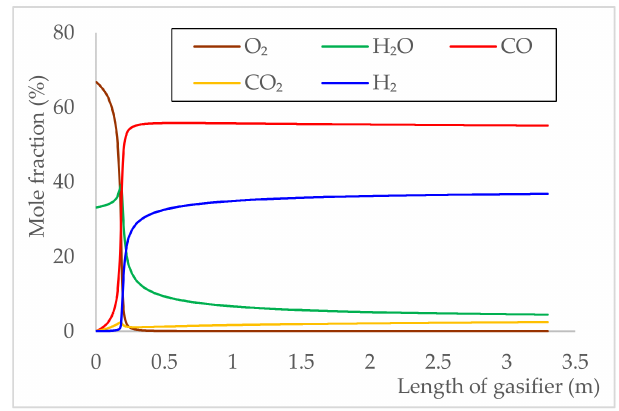
Figure 5. The profile of the major product gas mole